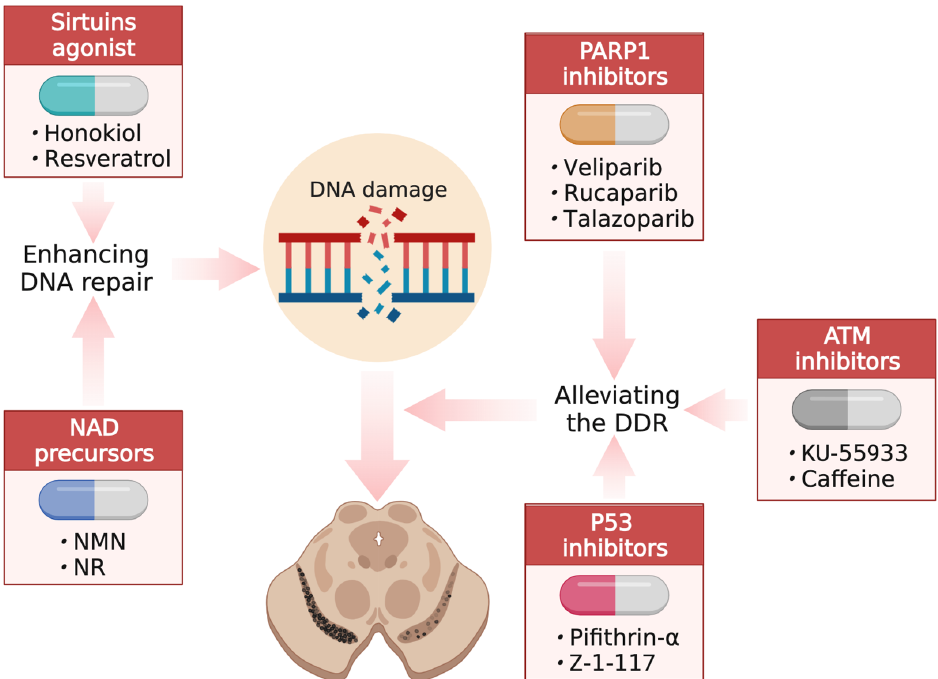
Figure 3. Therapeutic options for targeting DNA repair or DDR in PD. An overview of current compounds that target DNA repair or DDR in PD. Abbreviations: DDR, DNA damage response; NMN, nicotinamide mononucleotide; NR, nicotinamide riboside. (Created with BioRender.com).